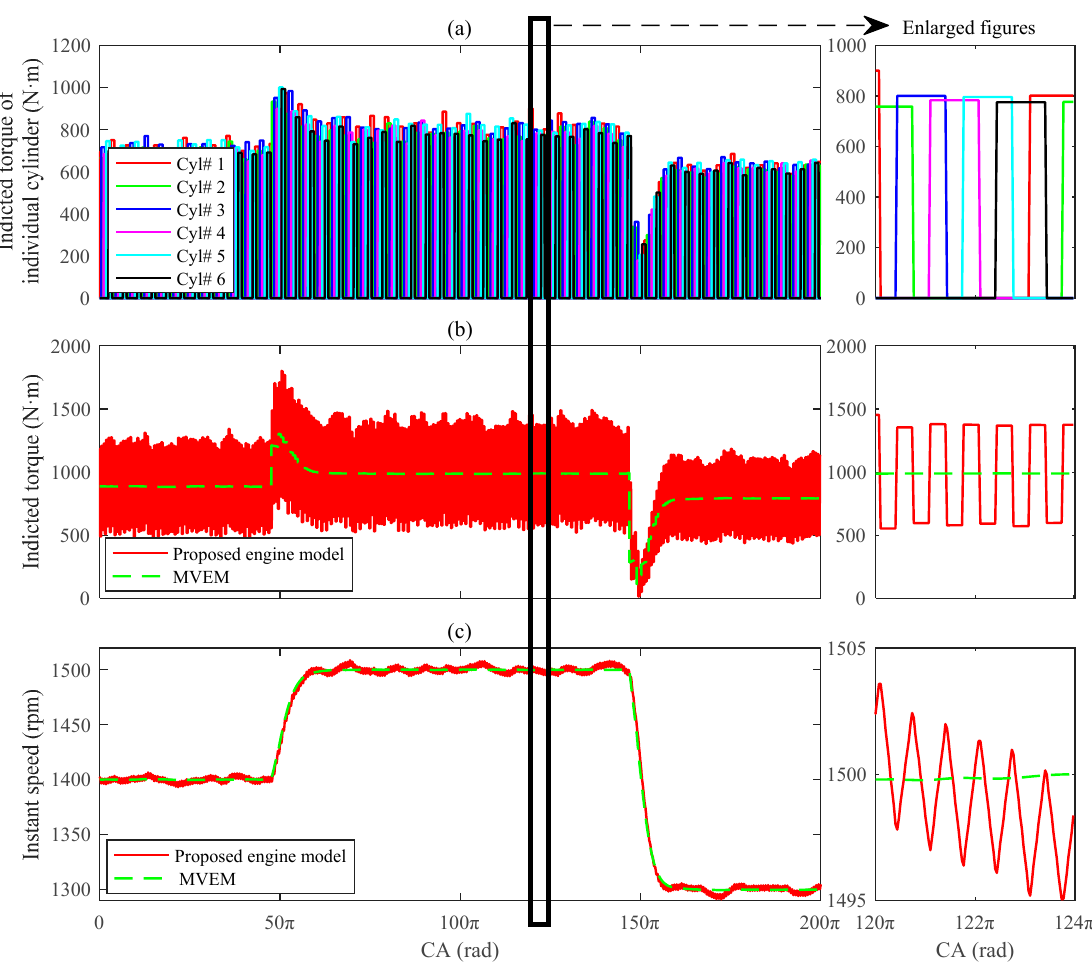
Figure 3. The comparisons between two engine models: ( a ) Individual cylinder indicated torque in the proposed hybrid engine model; ( b ) Total indicated torque in both engine models; ( c ) The speed responses in both engine models. (The sub-plots in the right side are the enlarged figures during one working cycle). MVEM: Mean Value Engine Model; CA: Crank-angle.